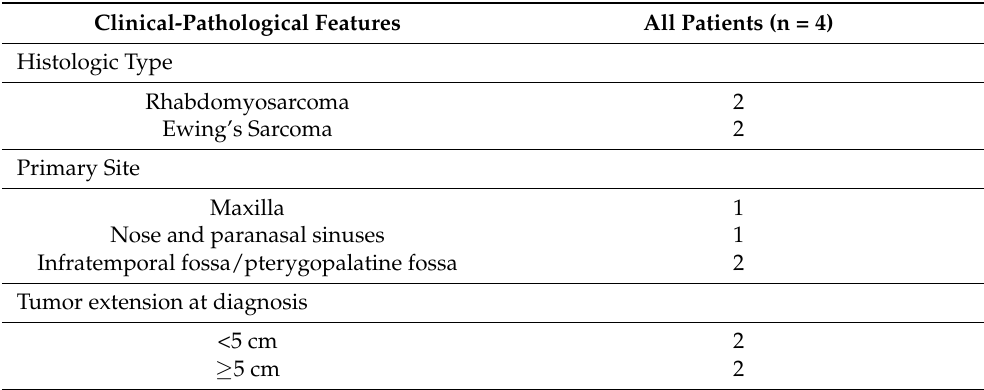
Table 2. Clinical-pathological characteristics of study